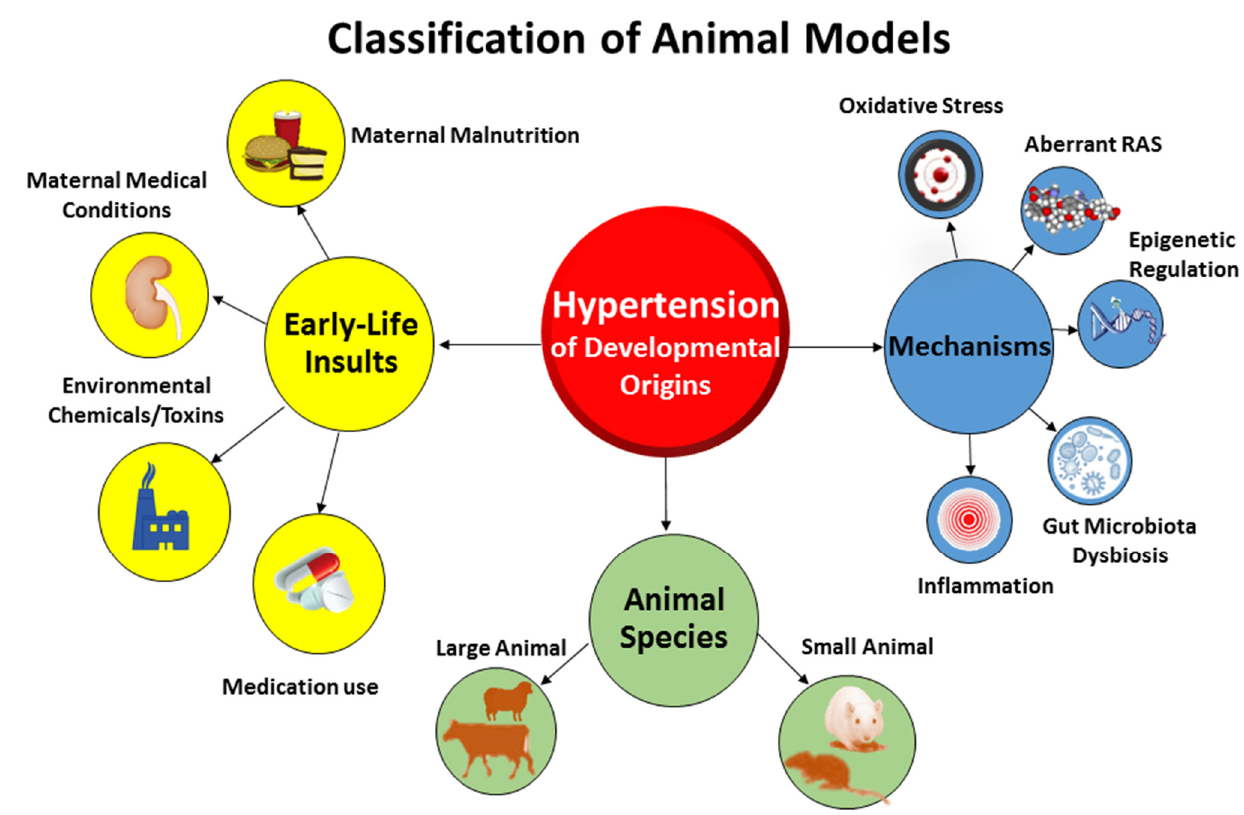
Figure 1. The classification of major animal models for studying hypertension of developmental origins.